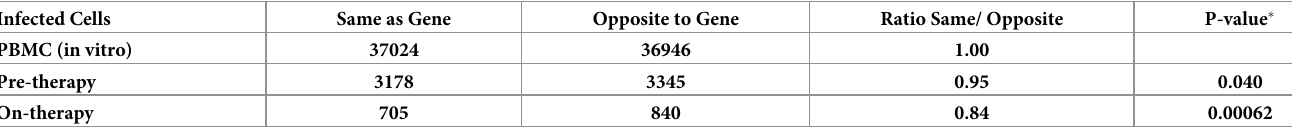
Table 12. Orientation of SIV integration sites relative to the surrounding gene. Infected Cells Same as